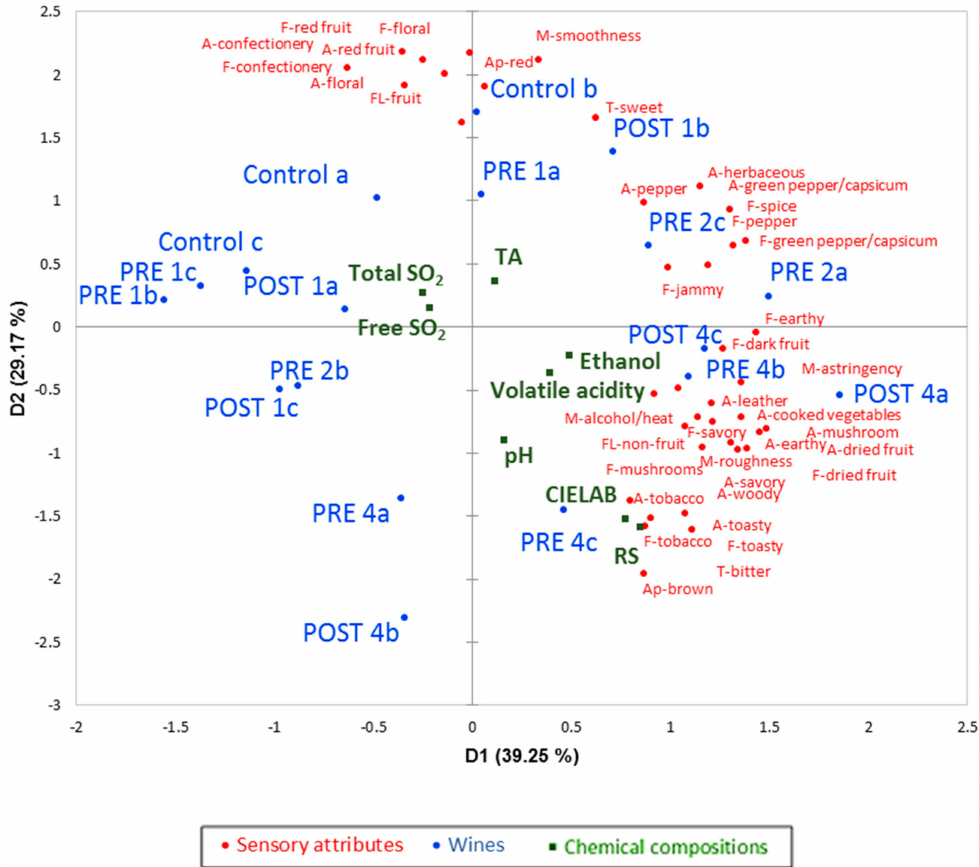
Figure 2. PCA biplot of mean sensory data obtained from the RATA panel ( n = 65) overlaid with basic chemical analyses as supplementary data for 18 wines (28 L ferments) made with and without GL extracts added pre- and post-fermentation. Prefix A- = aroma attribute, T- = taste, F- = flavor attribute, M- = mouthfeel, Ap- = appearance, FL- = aftertaste (fruit and nonfruit). Prefixes PRE = GL extracts added prior to fermentation (PRE 1, PRE 2, and PRE 4), POST = GL extracts added after fermentation process (POST 1 and POST